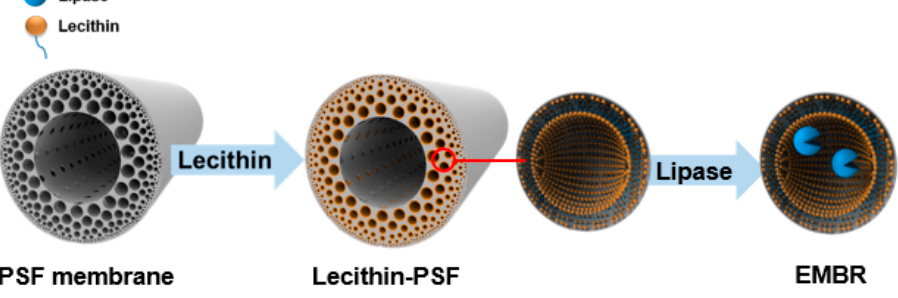
Figure 11. Schematic representation of lecithin modification and enzyme immobilization on the